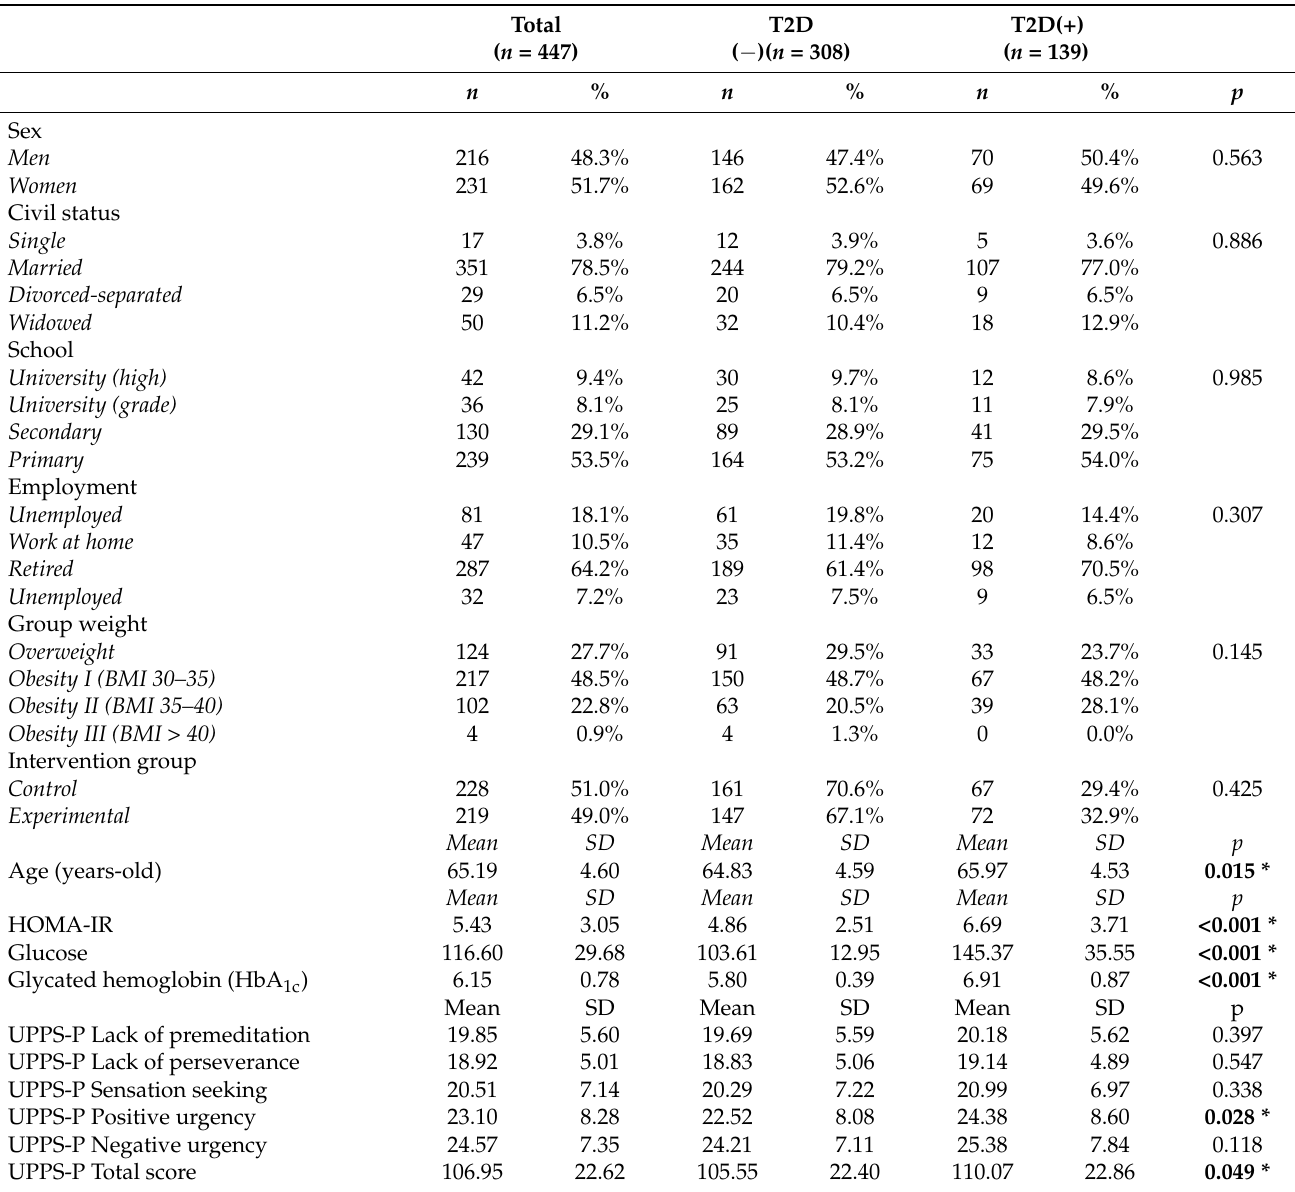
Table 1. Descriptive of the sample at